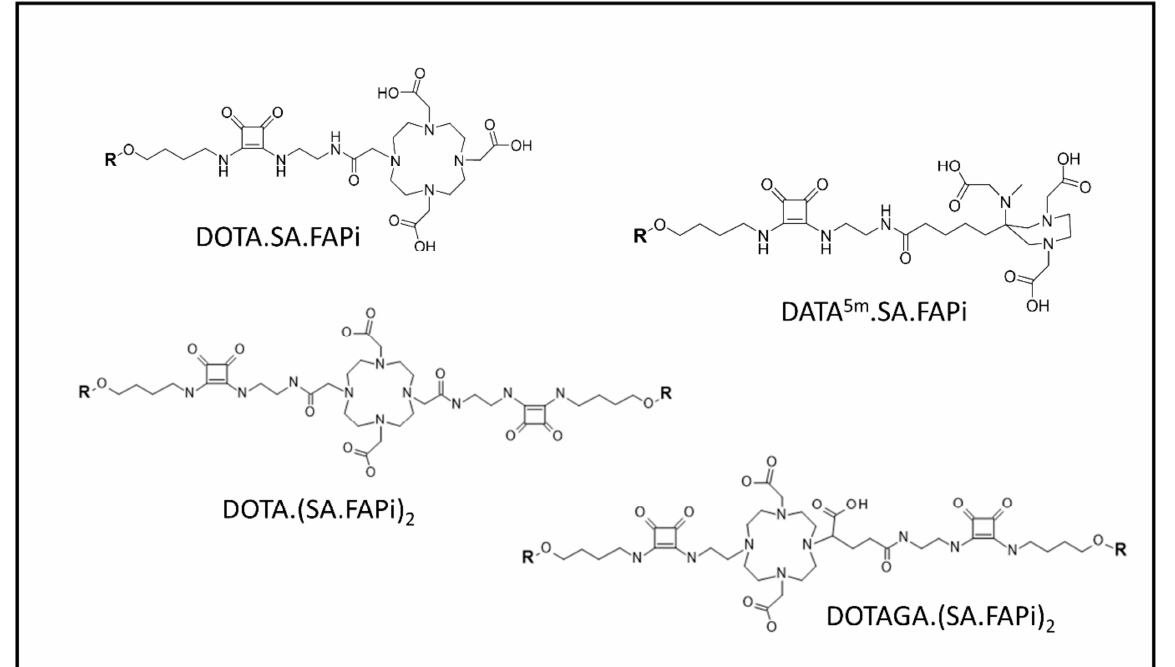
Figure 3. FAPI molecules developed by the Mainz research group [63] . Reprinted/Adapted from ref. [62] .